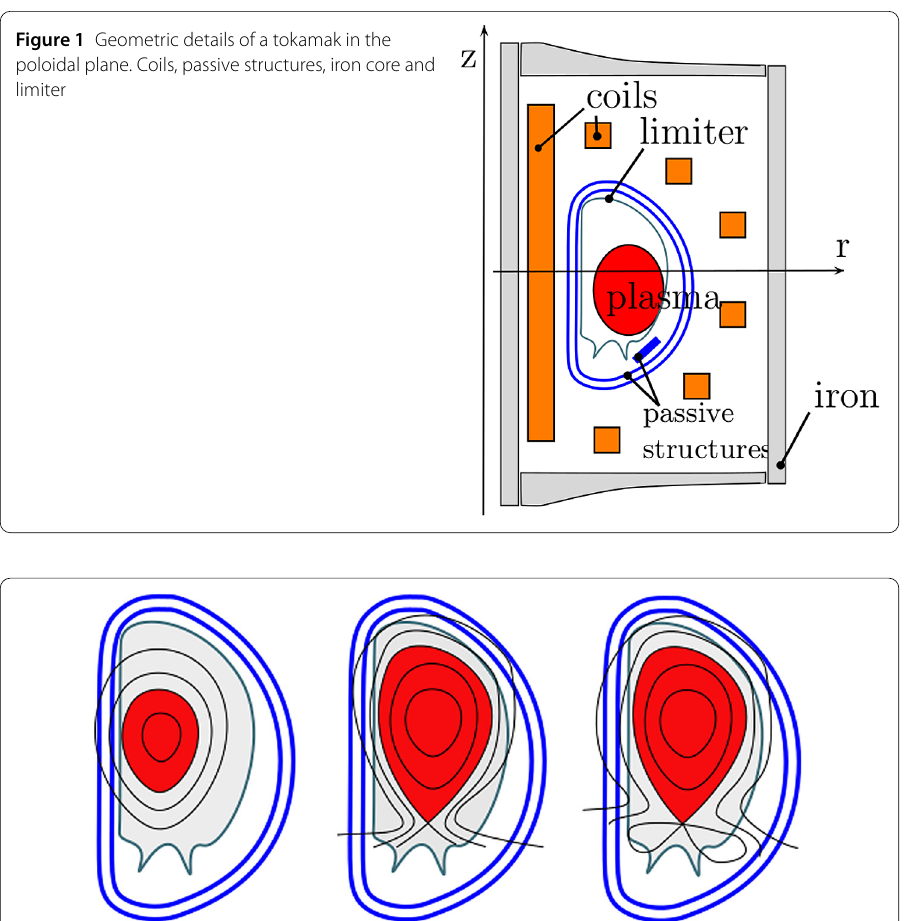
Figure 2 Sketch for characteristic plasma shapes. Contour lines (black) of the poloidal flux and plasma domain (red): The plasma boundary either (left) touches the limiter (gray) or the plasma is enclosed by a flux contour line (middle and right) that passes through a saddle point. This can be a non-degenerated (middle) in the X-point configuration or degenerated (right) saddle point in the snowflake